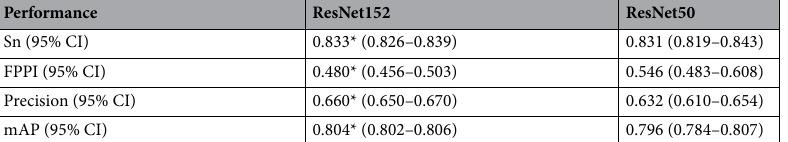
Table 3. Comparison of performance according to models. CI confidence interval, Sn sensitivity, FPPI false positive per image, mAP mean average precision. *Highest values of comparison